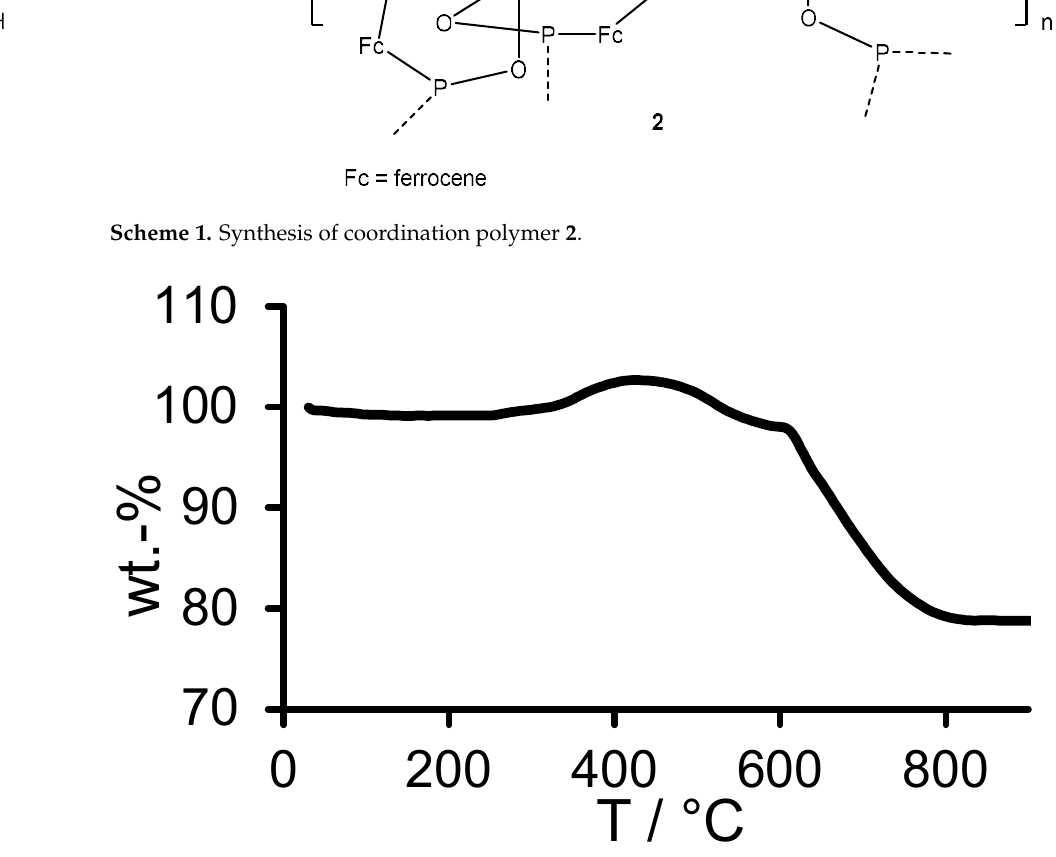
Figure 1. TG curves for Sm(III) CP 2 . Analysis of the powder diffraction pattern data also shows that all coordination polymers based on Sm, Dy, Eu, and Y are isostructural and phase pure (Figure 2) [26]. According to X-ray single crystal diffraction compound 2 is a two-dimensional 2D CP with the ligands being in eclipsed conformations with torsion P-C-C-P angles equal to c.a. 76 ◦ and c.a. 71 ◦ and exhibiting two types of coordination. Two ligands comprise a double O-P-O bridge between two Sm-ions with the formation of eight-membered cycles. The other two ligands form mono bridges between Sm (III) ions in different directions, thus binding these eight-membered rings, forming a two-dimensional structure running along the 0b axis and diagonal of the a0c plane (Figure